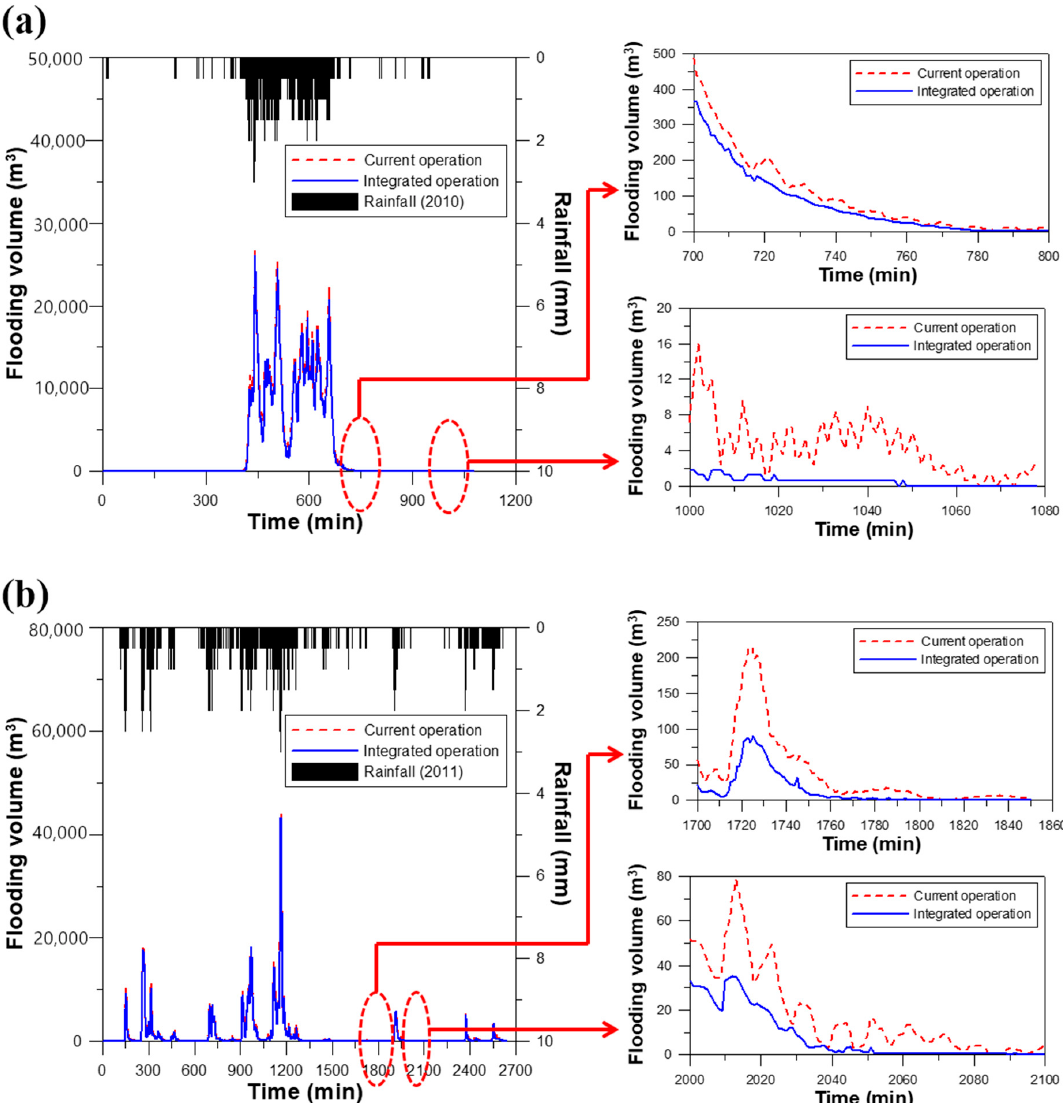
Figure 12. Rainfall and flooding volume over time: ( a ) 2010; ( b ) 2011.